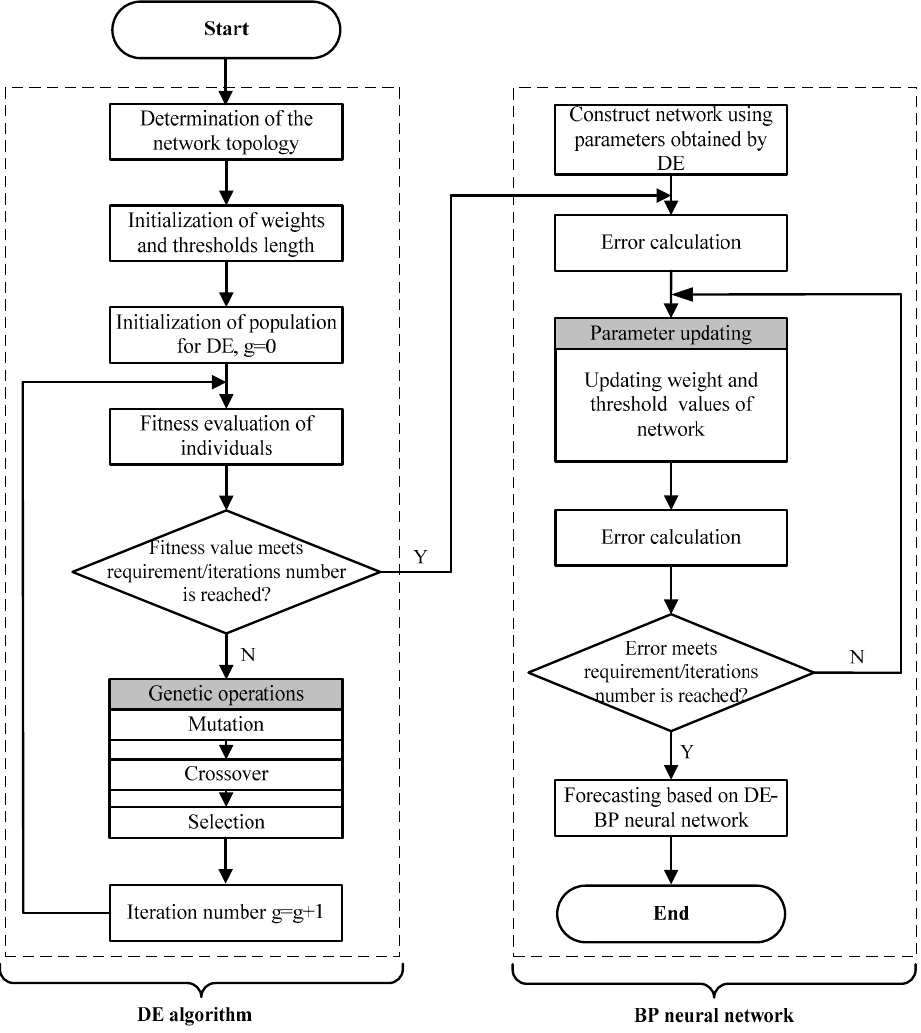
Figure 4. The flowchart of DE-BP model.